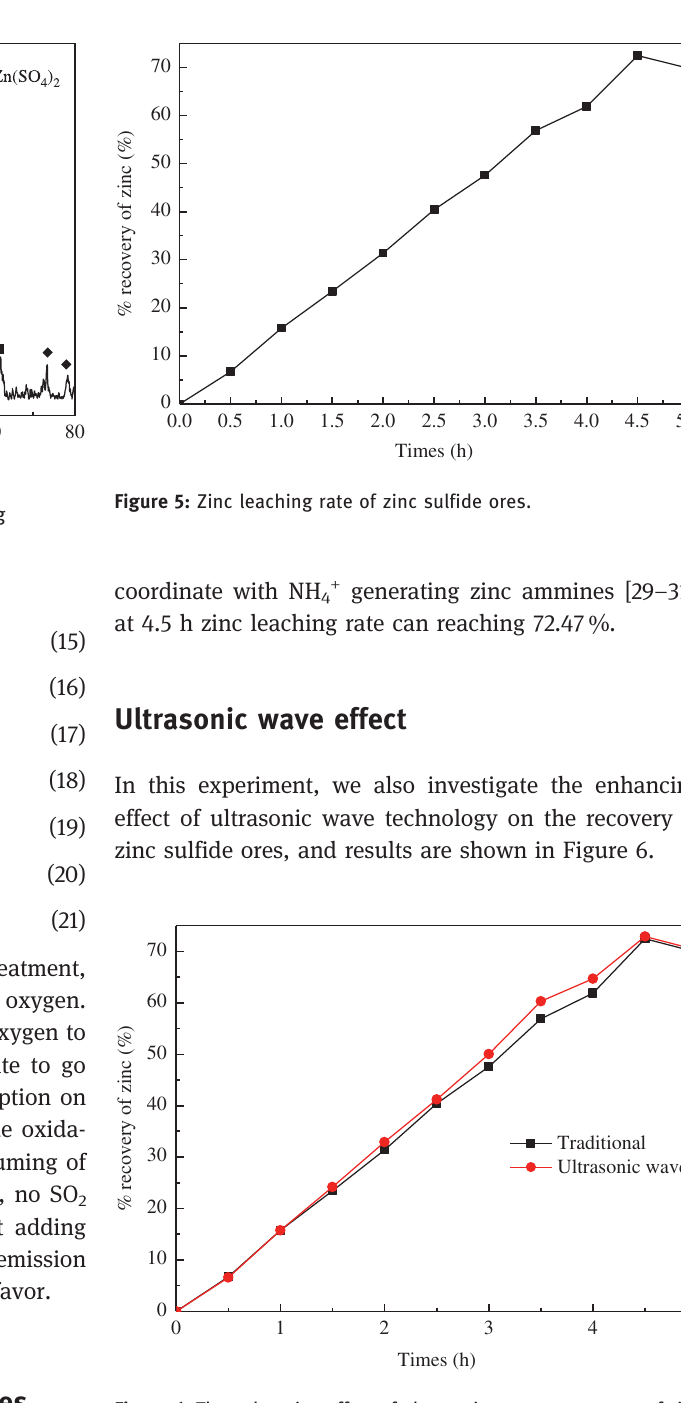
Figure 6: The enhancing effect of ultrasonic wave on recovery of zinc sulfide ores.